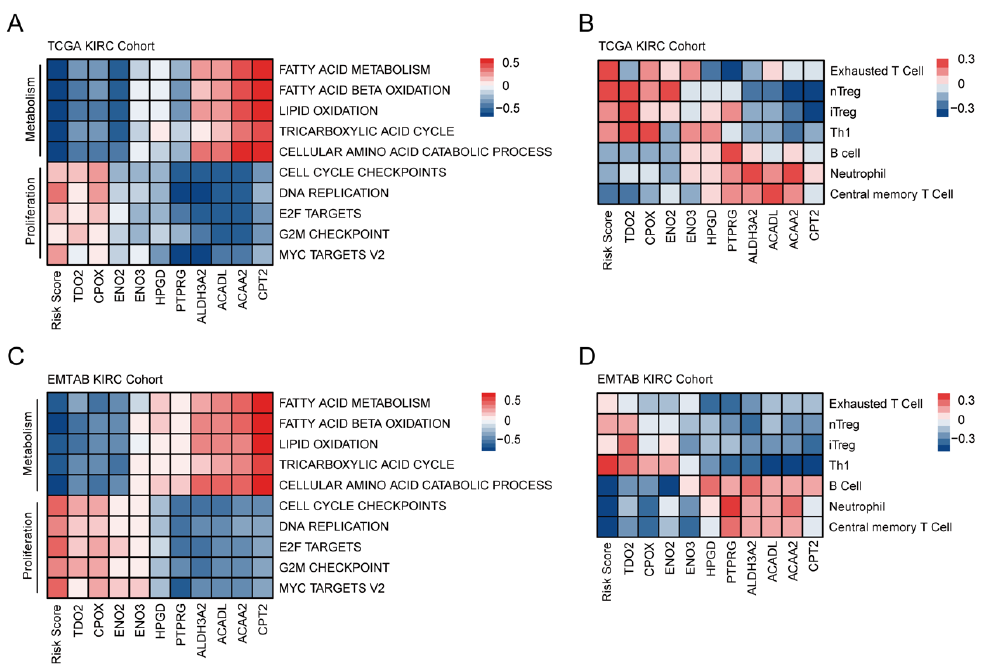
Figure 4. Results of GSVA and ImmuCellAI. Heatmap for correlations between GSVA scores, FAMGS risk scores and gene expressions in the TCGA training cohort ( A ) and EMTAB validation cohort ( C ). Heatmap for correlation between infiltration scores, FAMGS risk scores and gene expressions in the TCGA training cohort ( B ) and EMTAB validation cohort ( D ). GSVA: Gene set variation analysis;